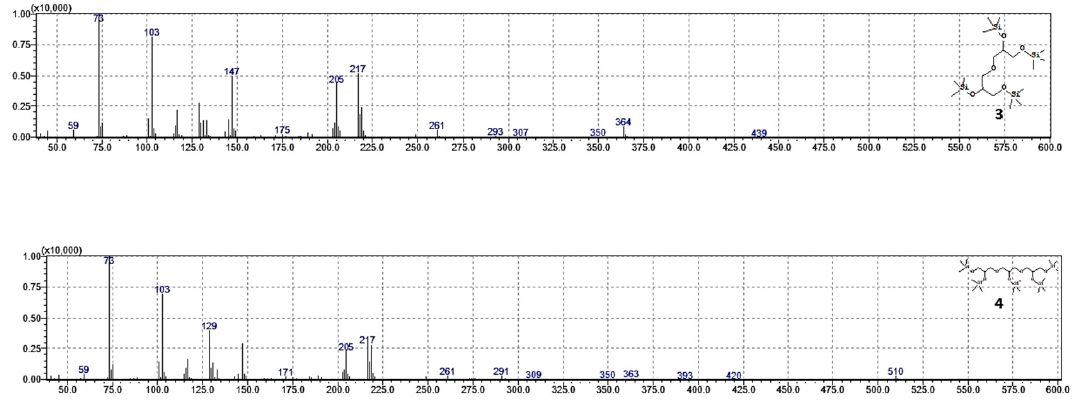
Figure 12. Mass spectra of dimer ( 3 ) and trimer ( 4 ) in EI mode.